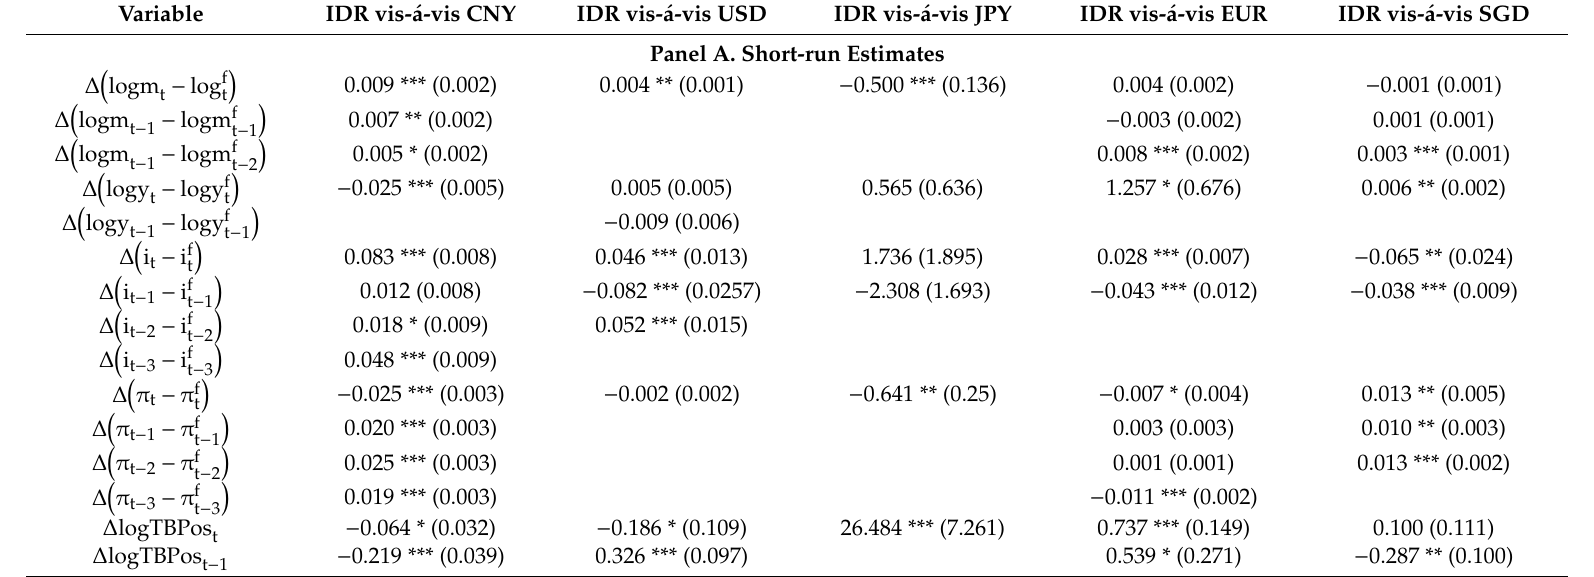
Table 3. The Result of Bounds Testing Approach under the Nonlinear ARDL